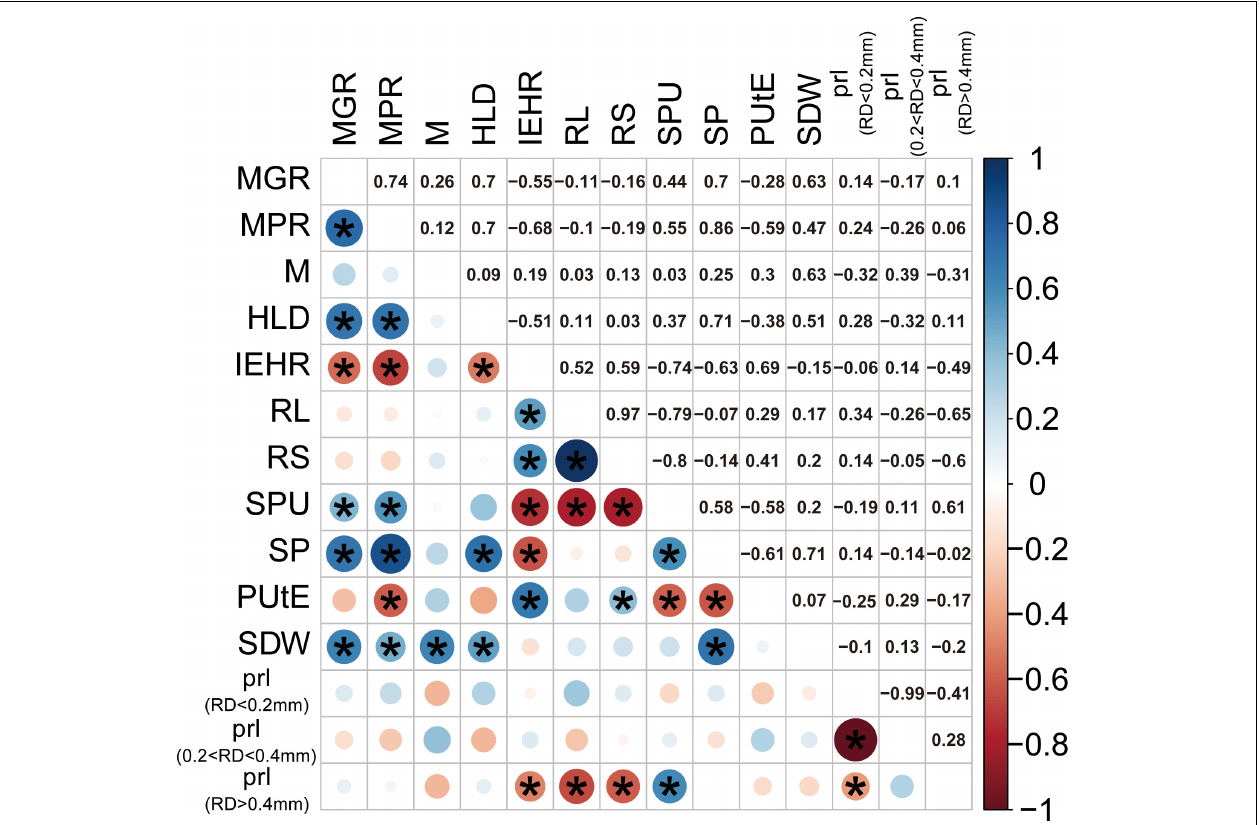
FIGURE 5 | Correlation matrix (Pearson) of SDW (g), SP content (mg), mycorrhizal responsiveness (MGR and MPR), root morphological traits, and mycorrhizal traits at low P levels. Blue circles indicate a positive correlation, red circles indicate a negative correlation, and the size and intensity of shading indicate magnitude. Correlations significant at p < 0.05 are marked with an asterisk. Corresponding measurements of each abbreviation: mycorrhizal colonization indicated by AM fungal gene copy number (M), HLD, RS, total RL, PUtE, SPU in shoots by unit of root length, mycorrhizal responsiveness (MGR and MPR), SDW, and SP content. In addition, we calculated the PRL, the percentage of the root length with different